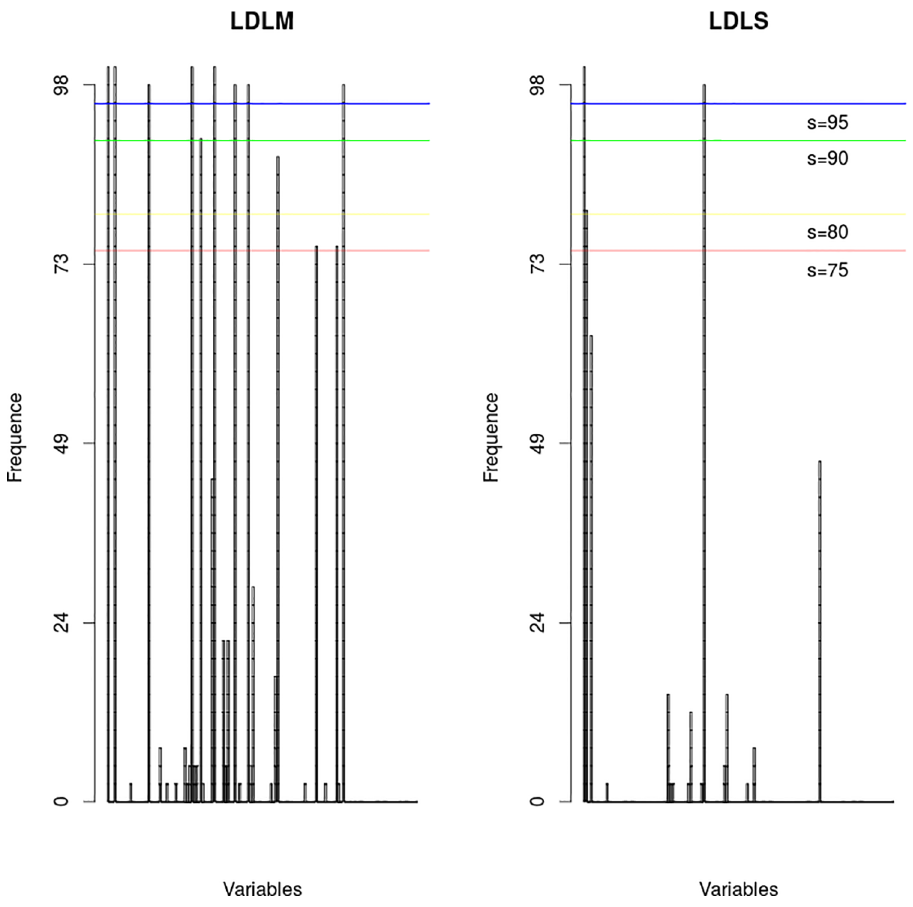
Fig 1. Frequent variables. The x-axis shows the variablesincluding the interactions, and the y-axis shows the percentage of presenceof the variables. The left figure corresponds to the LDLM strategy and the right figure corresponds to LDLS strategy. Each vertical band representsone